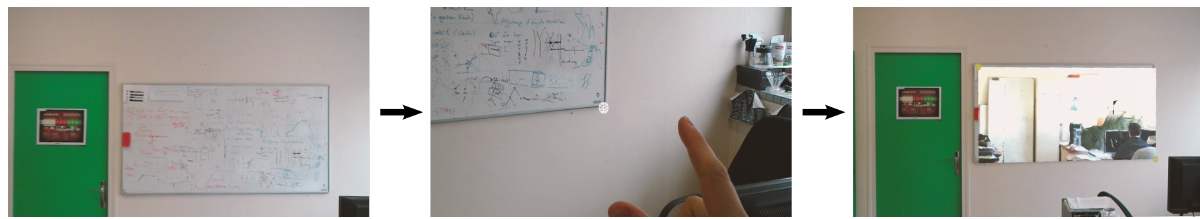
Figure 9. Capturing a vertical rectangle mask by 2-point picking on a white-board (left, then middle): the augmented data seen through the portal is indeed the photogrammetric model of the neighboring room, acquired by a DSLR camera and placed at its own real location